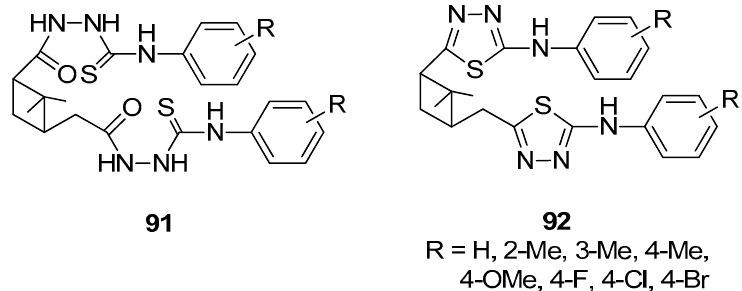
Figure 21. α -Pinene-based dithiadiazole compounds.